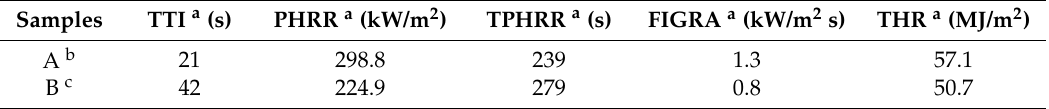
Table 2. Cone calorimeter data of MDFs and MDFs coated with PDMS@FDTS-Mg/Al LDH.